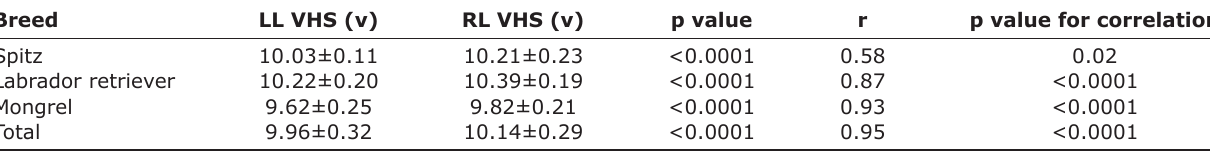
Table-3: Comparison and correlation between LL and RL VHS in Spitz, Labrador retriever and Mongrel dogs. Breed LL VHS (v) p value for